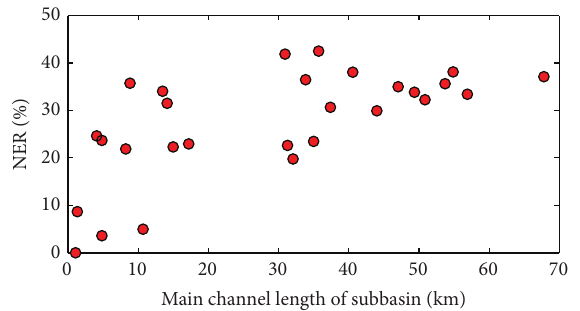
Figure 9: The NER (18) of the estimated reach flow storage on 28 subbasins with varying main channel length of subbasins.